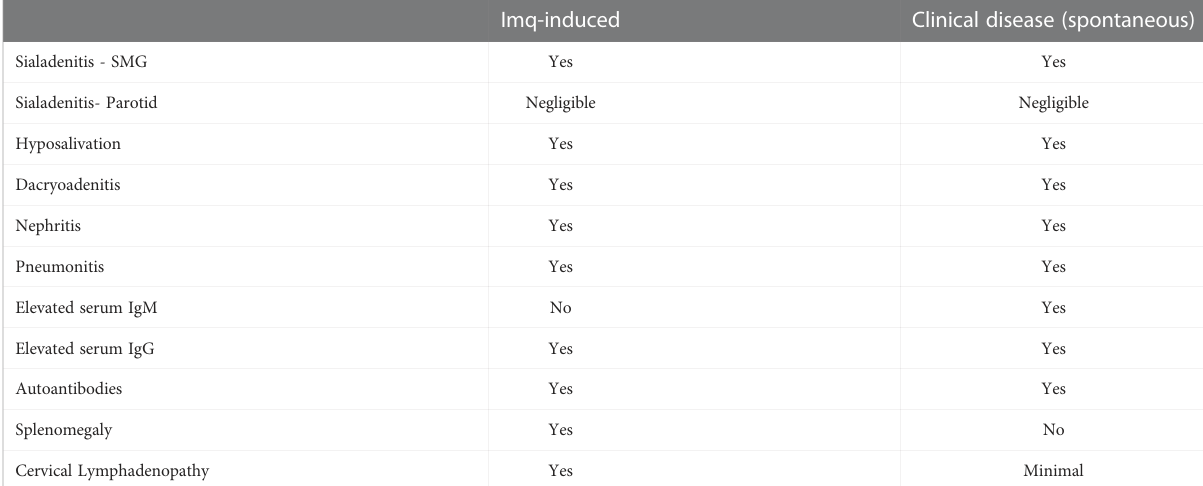
TABLE 1 Comparison of Disease Manifestations between Imq-treated NOD.B10 mice and clinical disease stage NOD.B10